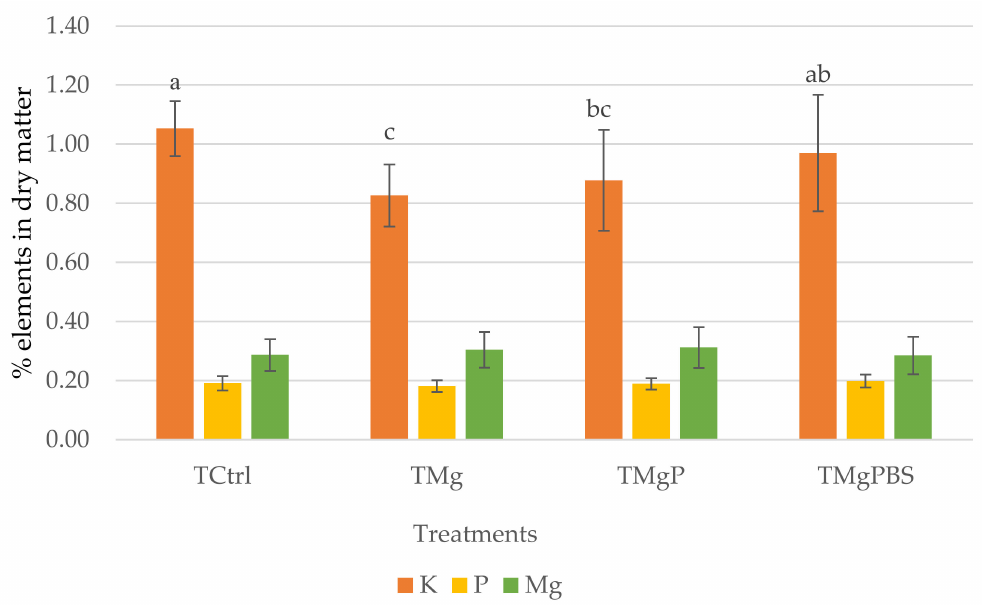
Figure 3. Leaf content of K, P, and Mg in % based on dry matter by treatments. (TCtrl—NPK, TMg—NPK + Agromag (6% MgO), TMgP—NPK + Agromag + Fosforo (30% P 2 O 5 ) and TMgPBS—NPK + Agromag + Fosforo + Bio Prot). Bars with no common letters are significantly